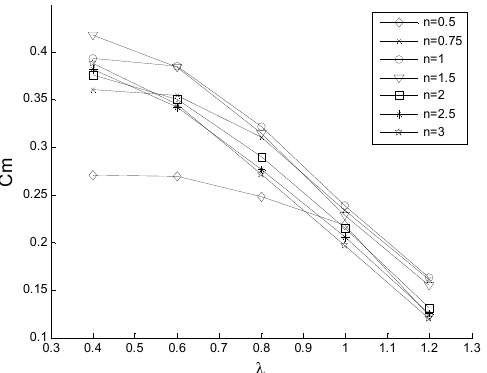
Figure 7. Coefficient of torque with respect to λ for turbines with different blade fullness.